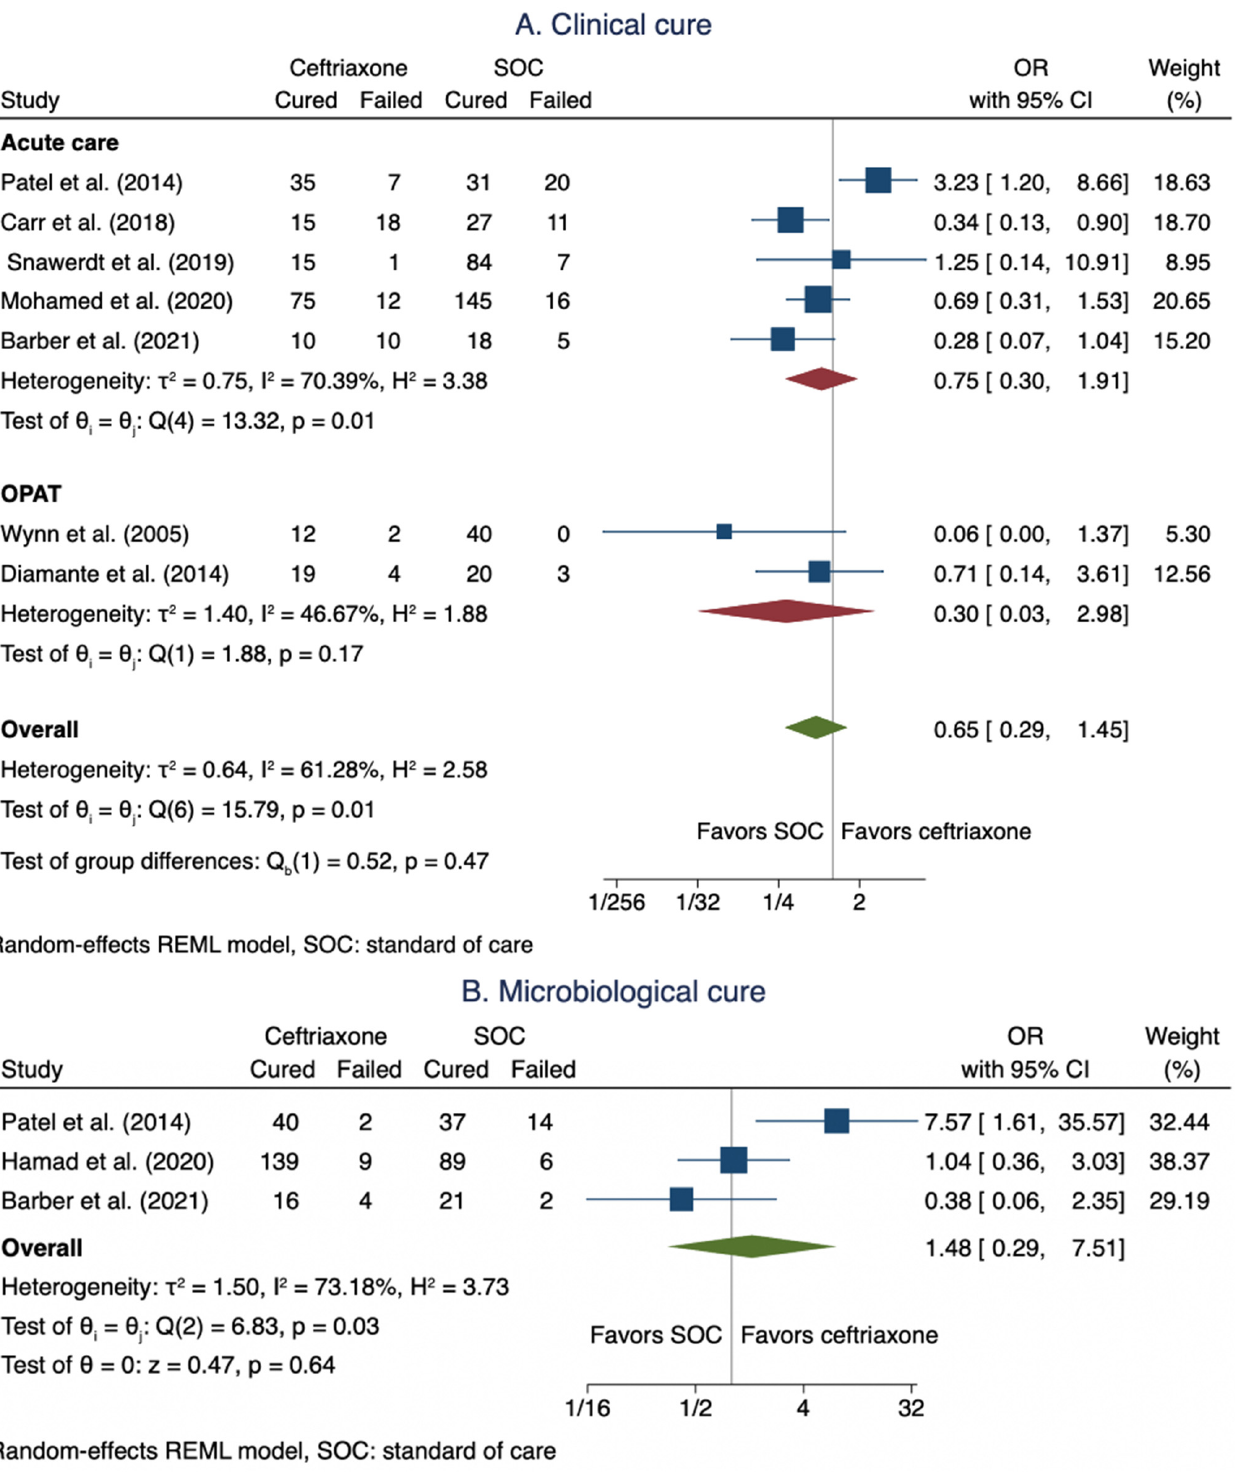
Figure 2. Meta-analysis of clinical cure ( A ) and microbiological cure ( B ).